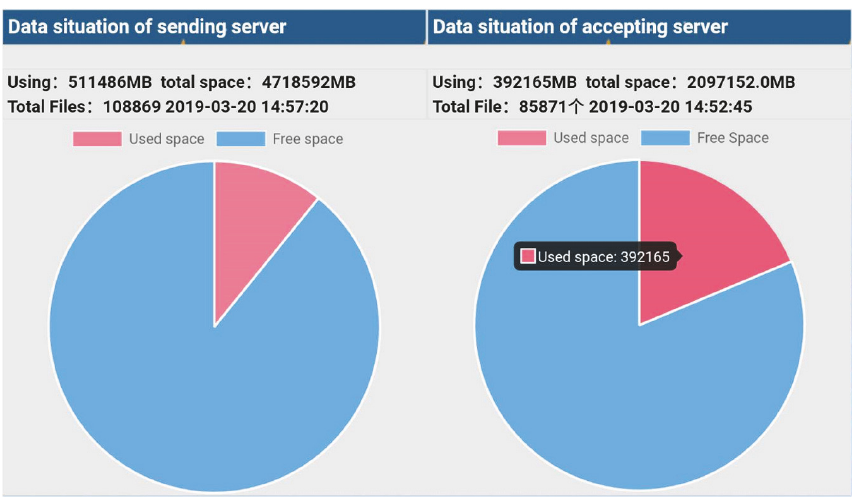
Figure 10: The second part of visualization web pages.